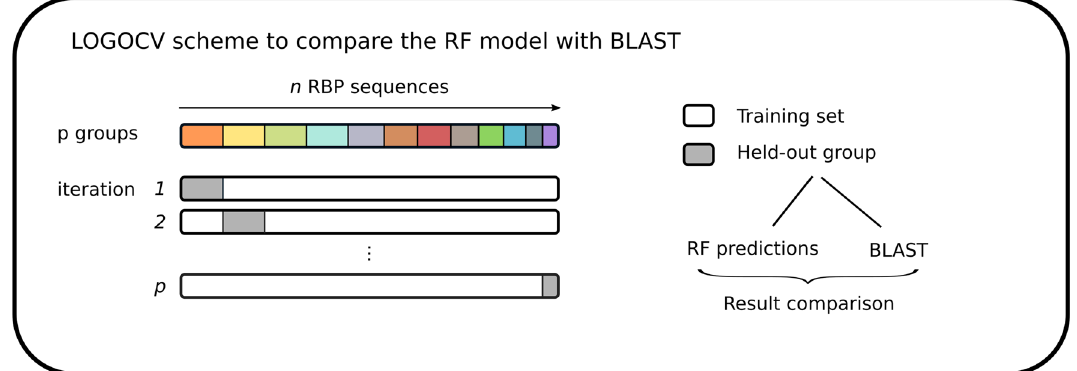
Figure 7. LOGOCV scheme used for the comparison of the final Random Forest (RF) model with BLASTp. An RF model is iteratively trained on all but one of p held-out groups. In every iteration, the trained model is used to make predictions for the held-out group. The sequences in the same held-out group are also subjected to a local BLASTp search against the database without the held-out group. Finally, both results are